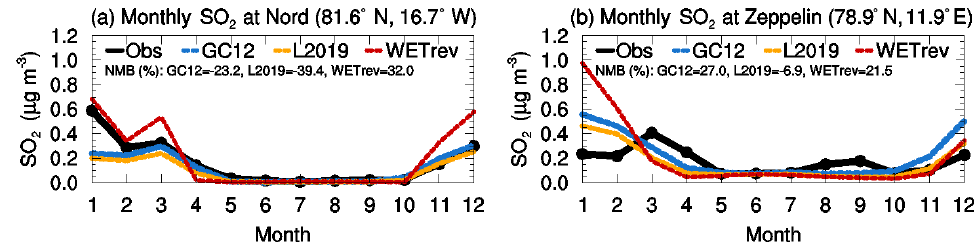
Figure 6. Variations of multiyear monthly means showing the comparisons of SO 2 surface mass concentrations which were observed at (a) Nord (2008–2013) and (b) Zeppelin (2008–2013) sites (black) and simulated (2011) by GC12 (blue), L2019 (yellow), and WETrev (red)